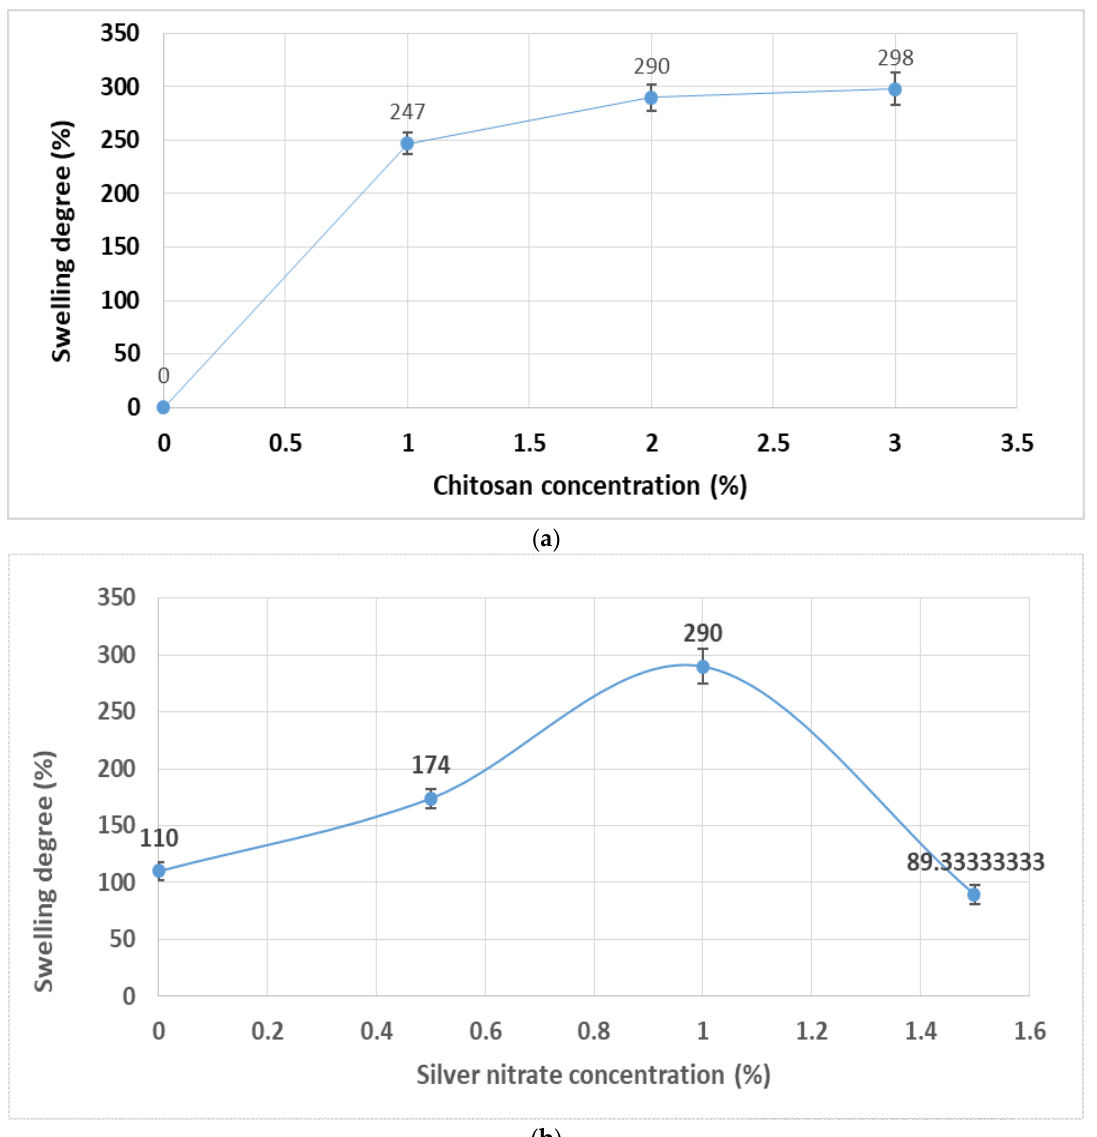
Figure 2. ( a ) effect of chitosan concentration on the swelling degree of the hydrogel, ( b ) effect of silver nitrate concentration on the swelling degree of the hydrogel. nitrate concentration on the swelling degree of the